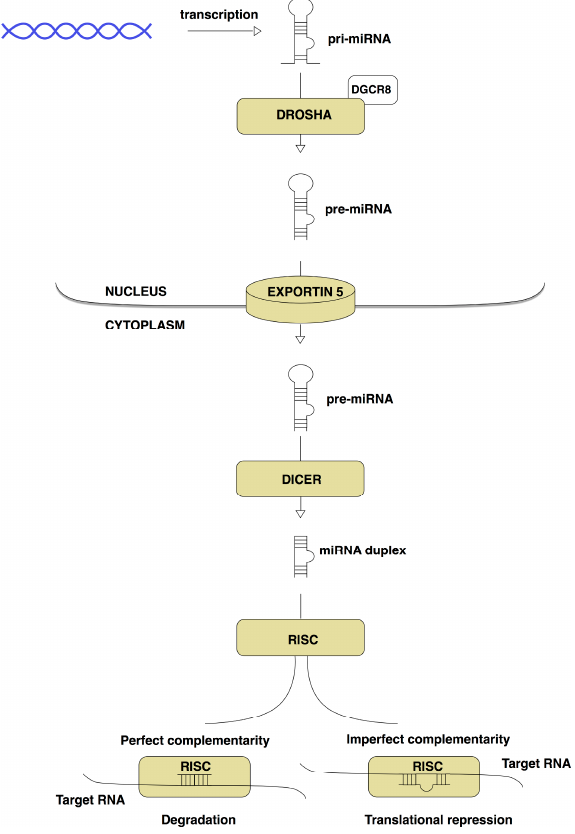
Figure 1. Biogenesis of miRNA. miRNAs genes are transcribed as long primary transcripts primary microRNA (pri-miRNA), which are subsequently processed by RNA polymerase II Drosha resulting in precursor miRNA (pre-miRNA) hairpins with a length of about 70 nucleotides. Pre-miRNAs are exported into the cytoplasm through the Exportin 5 protein and then cleaved by the Dicer complex to imperfect miRNA-miRNA* duplexes about 22 nucleotides in length. miRNA duplexes are separated to form the mature miRNAs and short single stranded miRNAs are incorporated into the RNA-induced silencing complex (RISC) causing the translational repression or mRNA degradation.